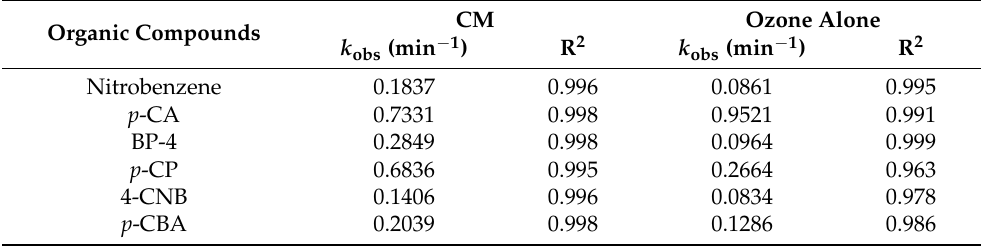
Table 3. Reaction kinetics of organic pollutant removal by CM catalytic oxidation. Organic